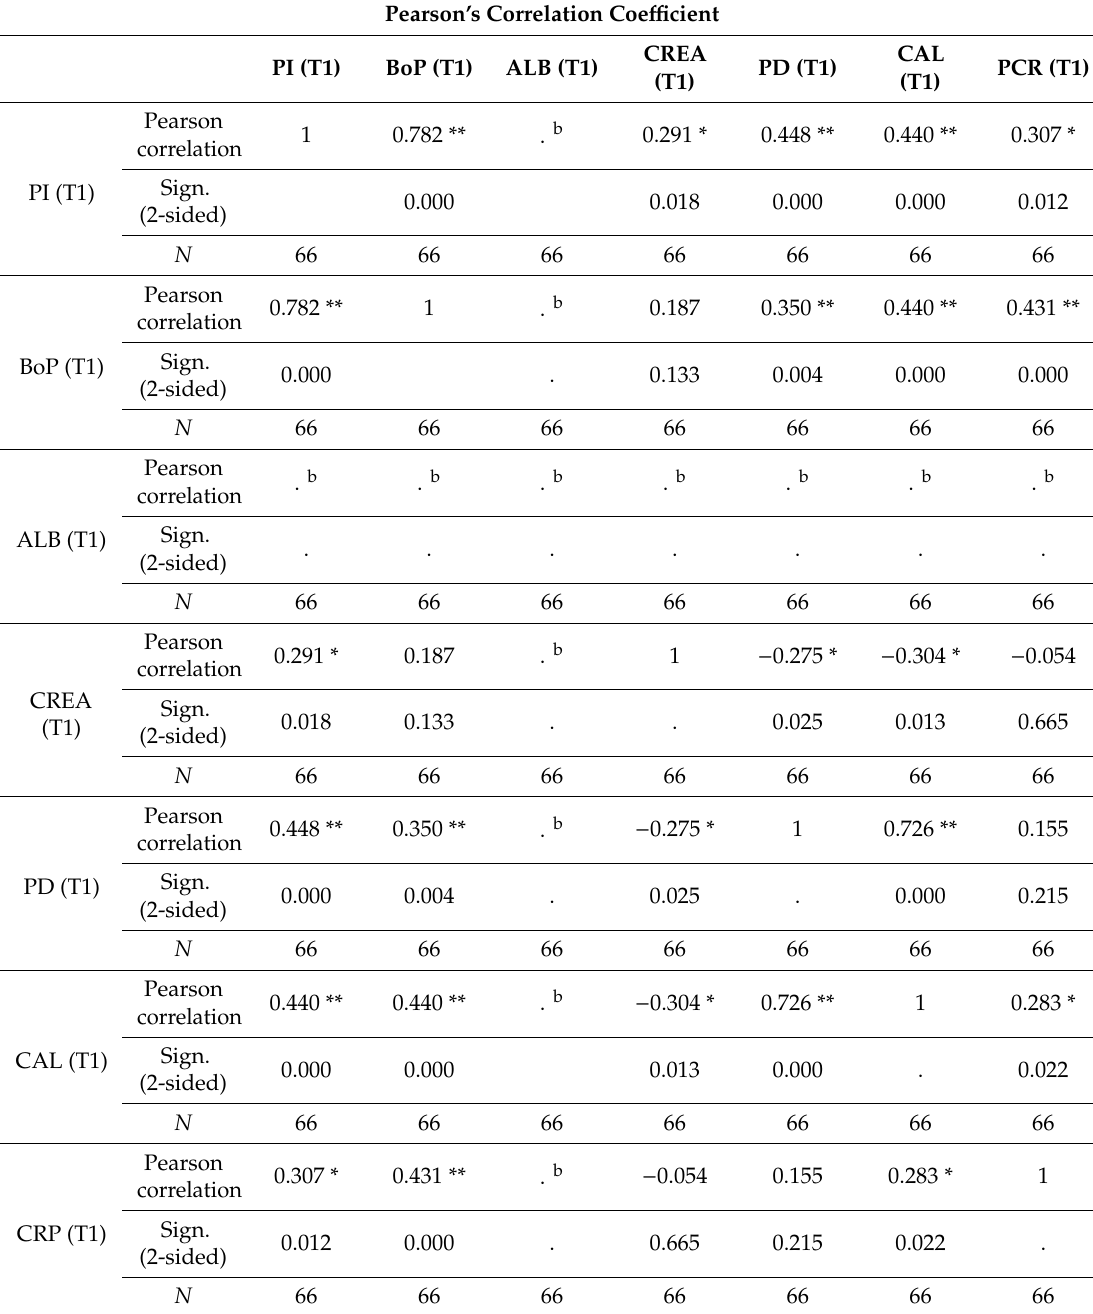
Table 4. Pearson’s correlation coe ffi cient of variables at